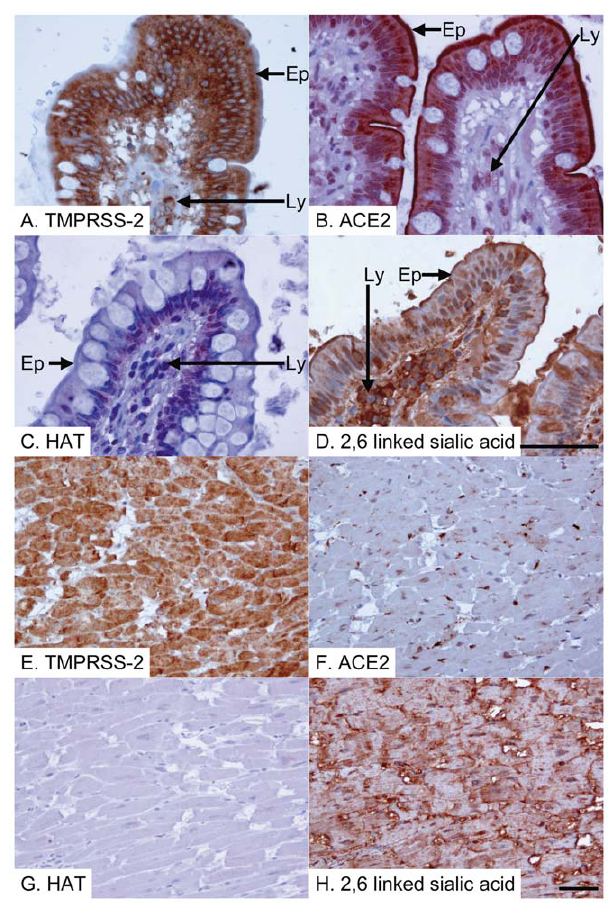
Figure 4. Ileal & myocardial expression of SARS-CoV and influenza virus activating proteases and receptors. Ileum (A–D) and myocardium (E–H) immunostained for TMPRSS2 (A&E), ACE2 (B&F) and HAT (C&G), or stained for 2,6-linked sialic acid (D&H; detected with elderberry ( Sambucus nigra ) lectin). All positive reactions are detected with the peroxidase technique (brown) and the tissue is counterstained with haematoxylin (blue). (A) There is strong positive anti-TMPRSS2 immunostaining of ileal epithelium (Ep) and also of lymphocytes (Ly) within the core of the villus. (B) There is strong positive anti-ACE2 immunostaining of ileal epithelium (Ep) and also of lymphocytes (Ly) within the core of the villus. (C) There is strongly positive anti-HAT immunostaining of the basal part of the ileal epithelial cells (Ep), but only weak positive immunostaining of occasional lymphocytes (Ly) within the villus core. (D) All structures are strongly stained for 2,6-sialic acid, including ileal epithelium (Ep) and lymphocytes (Ly). (E) There is strong positive anti-TMPRSS2 immunostaining of cardiac myocytes. (F) There is strong positive anti-ACE2 immunostaining of some cardiac myocytes. (G) There is no anti-HAT immunostaining of cardiac myocytes. (H) There is strong 2,6-sialic acid staining of cardiac myocytes. Scale bar=50 microns (shown in panels D and H and also pertaining to 3 preceding panels in each case).